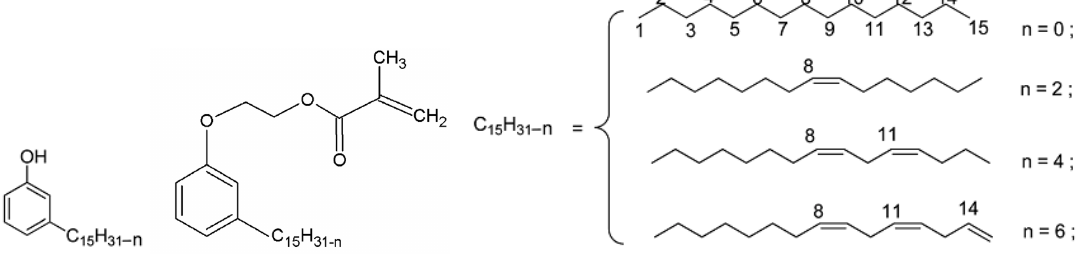
Figure 2. Structure of cardanol and a cardanol-based monomer. Adapted from [22] with permission from The Royal Society of Chemistry.